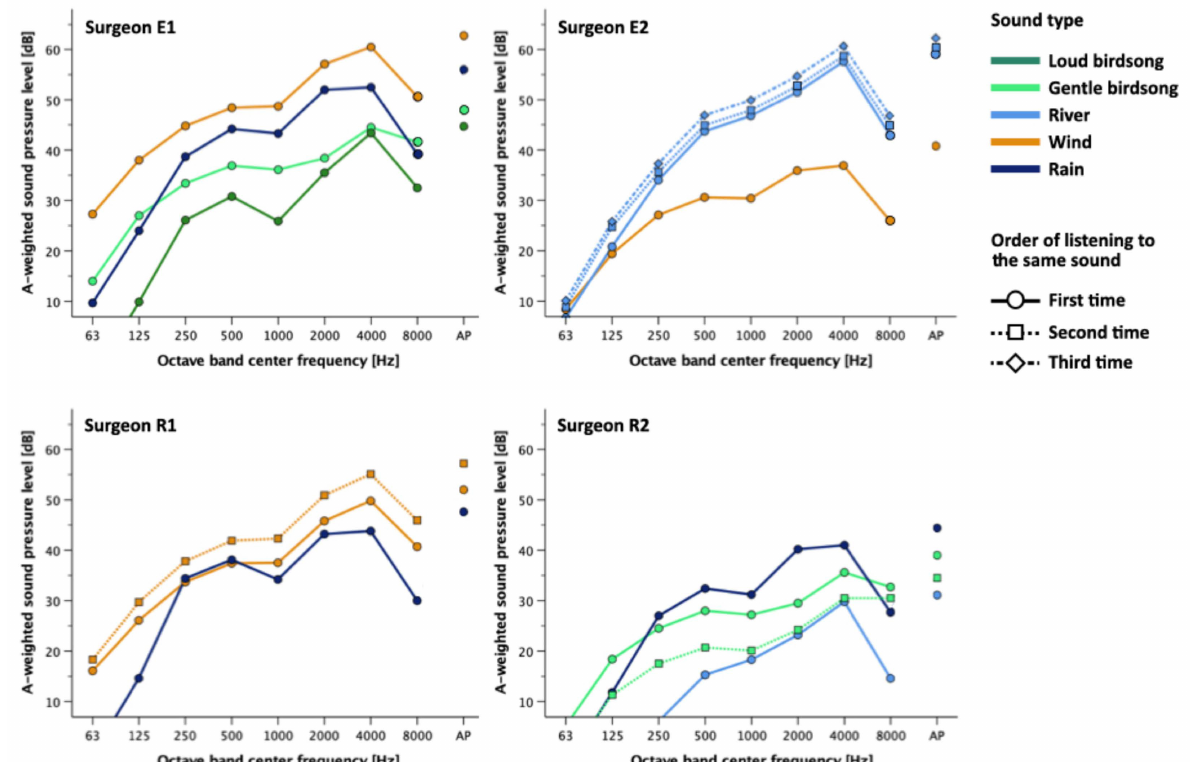
Figure 3. Type of sound and the sound frequency characteristics of equivalent continuous A-weighted sound pressure levels in each experiment. Note. AP = All